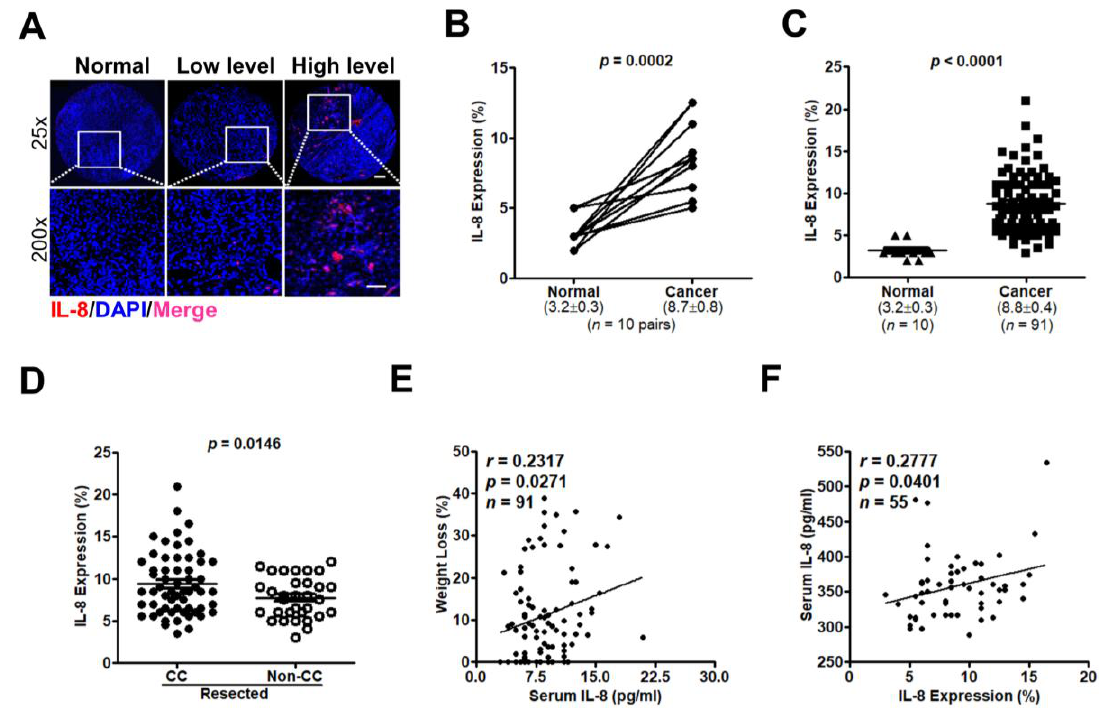
Figure 8. Representative immunofluorescence images showing IL-8 expression in normal and tumor samples. ( A ) Tissue microarray cores are shown at × 25 original magnification (Bar = 200 µ m). The area in the white rectangle is shown as a magnified view below the image (Bar = 50 µ m; × 200 magnification). The paraffin-embedded patient tissue samples were stained with anti-IL-8 antibody (red) and DAPI (4 (cid:48) ,6-diamidino-2-phenylindole) for cell nuclei (blue). ( B ) IL-8 expression was compared between PC specimens and their normal counterparts. ( C ) IL-8 expression levels (mean ± standard error of the mean) were compared between normal and PC tissues. ( D ) PC patients with or without CC showed different levels of IL-8 in tumor tissues. ( E ) Pearson’s correlation analysis demonstrated that IL-8 expression level in tumor tissues was positively correlated with weight loss. ( F ) The correlation between IL-8 expression in tumor specimens and IL-8 levels in serum samples was analyzed by Pearson’s correlation analysis. Table 2. The clinicopathologic characteristics and expression of IL-8 in pancreatic tumor specimens. Tissue Expression (%) Characteristic Low ( n = 52) High ( n = 39)